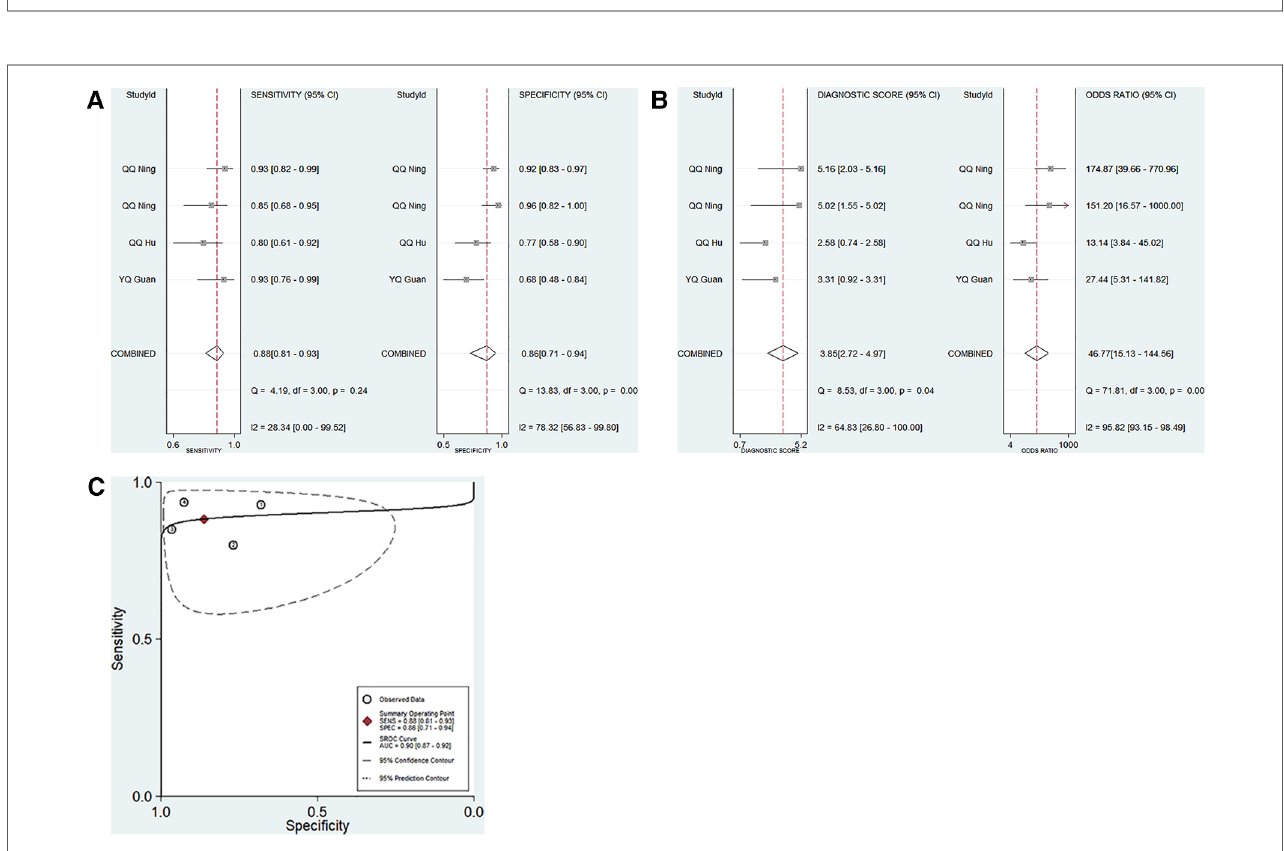
FIGURE 4 Pooled results of the studies on ncRNAs combined with other laboratory indexes for KD among 4 studies included in the meta-analysis. ( A ) Pooled sensitivity and speci fi city; ( B ) Pooled DOR; ( C ) SROC.